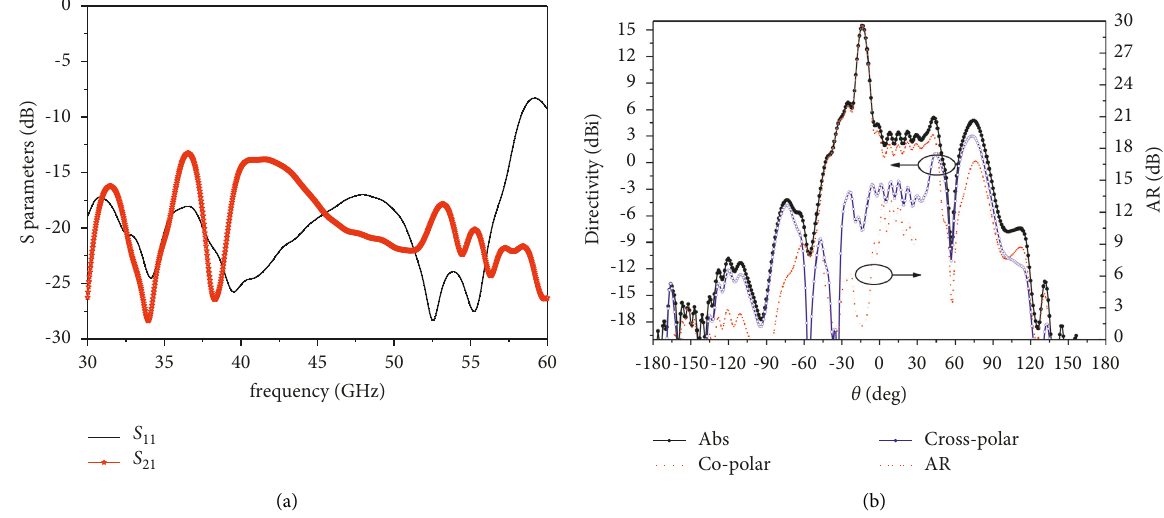
Figure 2: Simulated results of (a) S parameters and (b) the radiation pattern and axial ratios in the xz -plane at